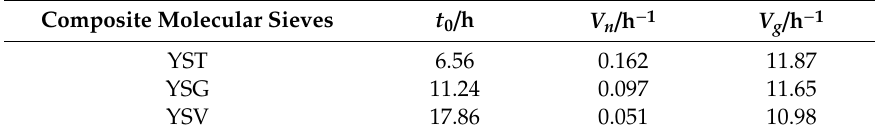
Table 1. Induction period apparent nucleation rate and apparent crystal growth rate during the hydrothermal synthesis of YST, YSG, and YSV composite molecular sieves.